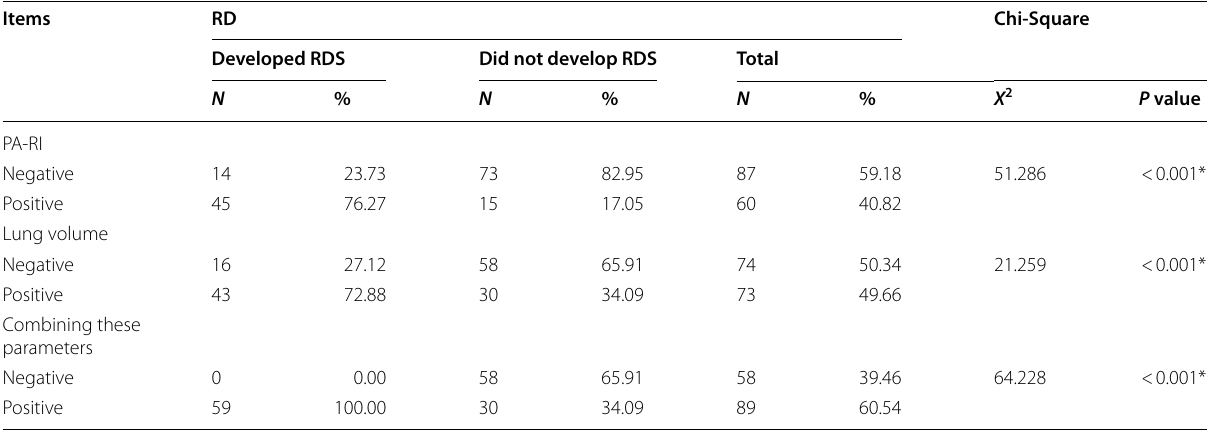
Table 2 Comparison of predictive number for detection of RDS using either PA‑RI or Lung volume or by combining both measurements